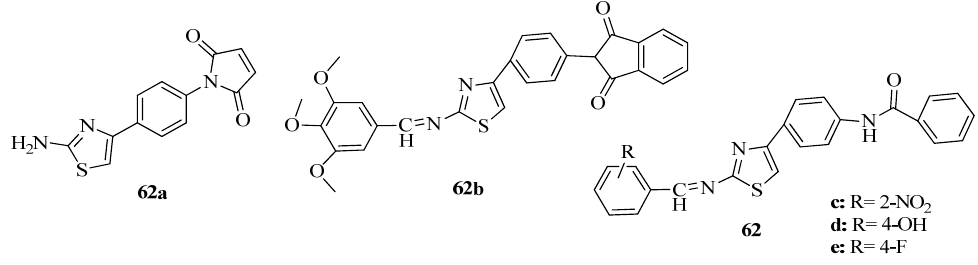
Figure 24. Structures of 2-amino thiazole Schiff bases.